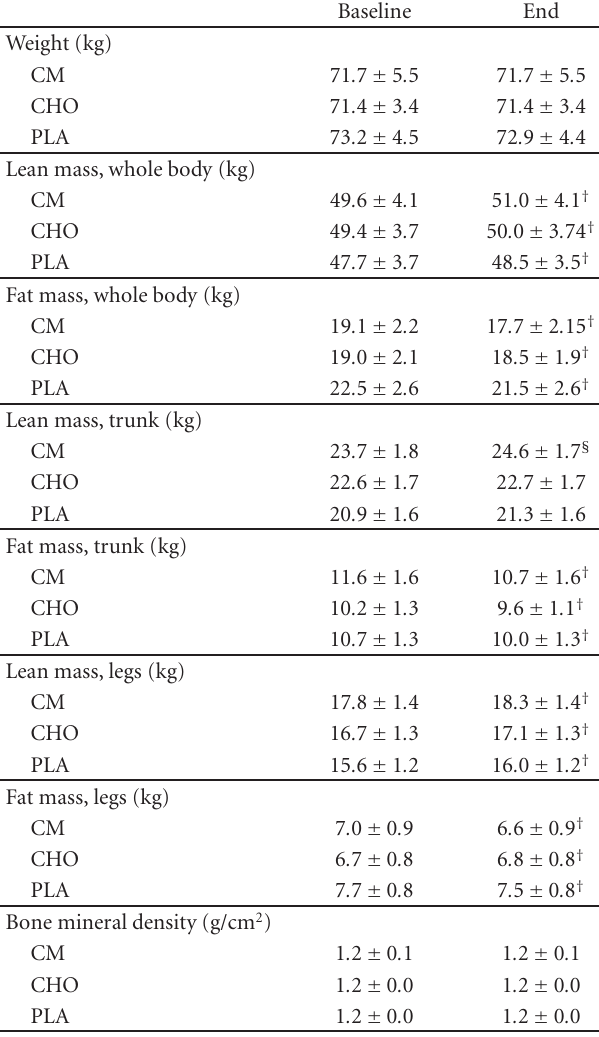
Values are mean ± SE. Significant di ff erences: † , significant time e ff ect; § , CM versus CHO ( P < .